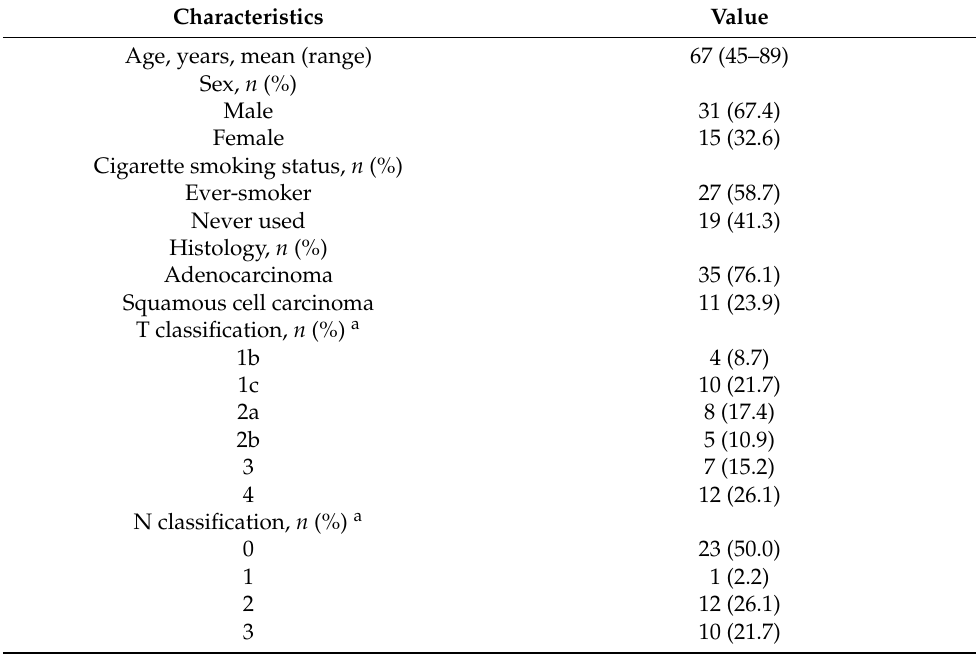
Table 2. Patient characteristics in this study ( n =